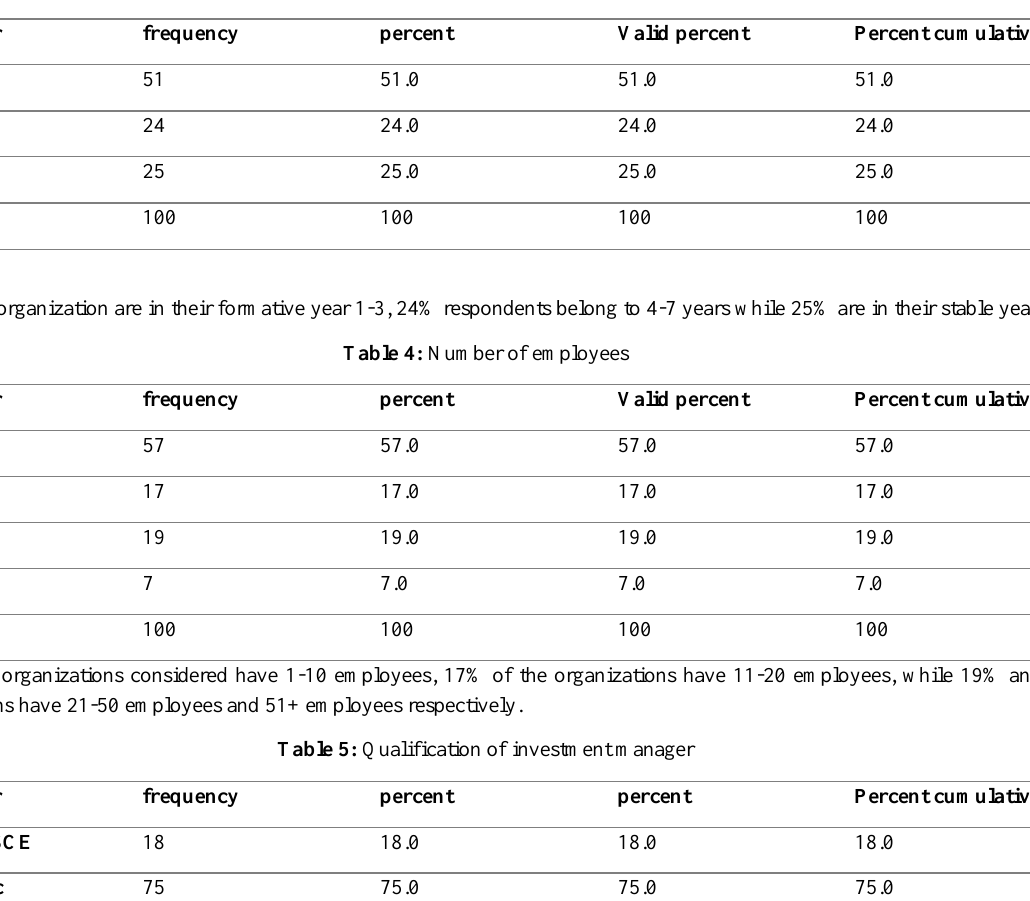
Table 3: Number of year in operation